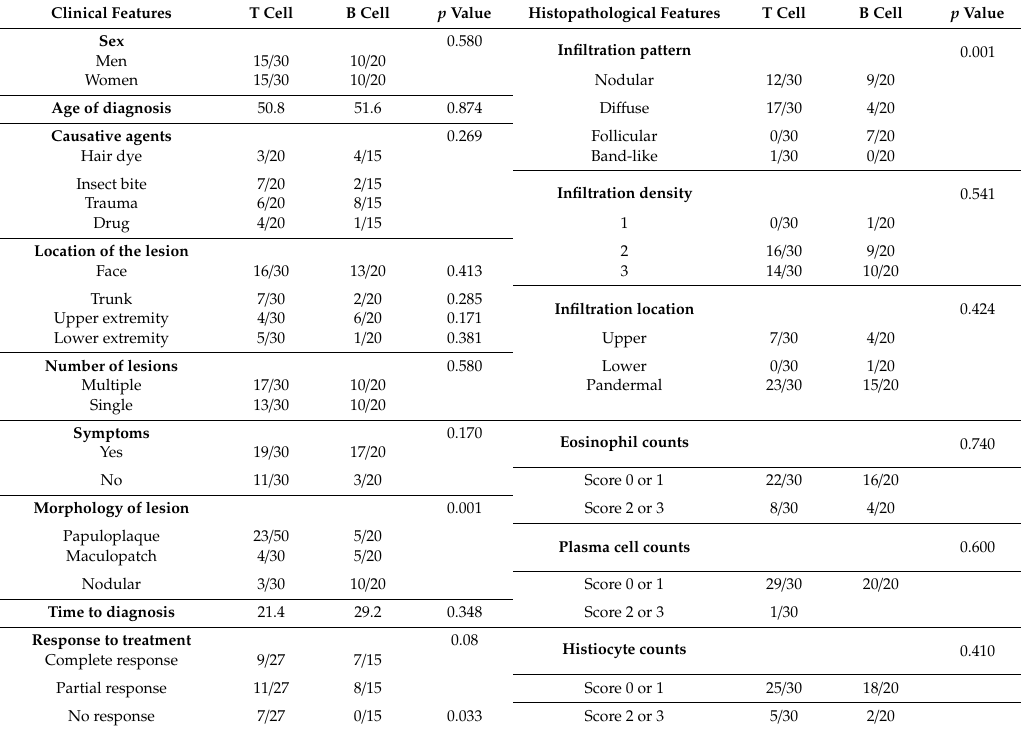
Table 3. Clinicohistopathological characteristics of cutaneous lymphoid hyperplasia patients according to dominant lymphocyte type (T cell vs B